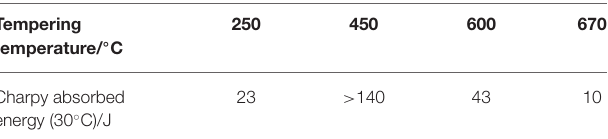
TABLE 1 | Charpy absorbed energy of CB10 steel at − 30 ◦ C vs. tempering temperature.